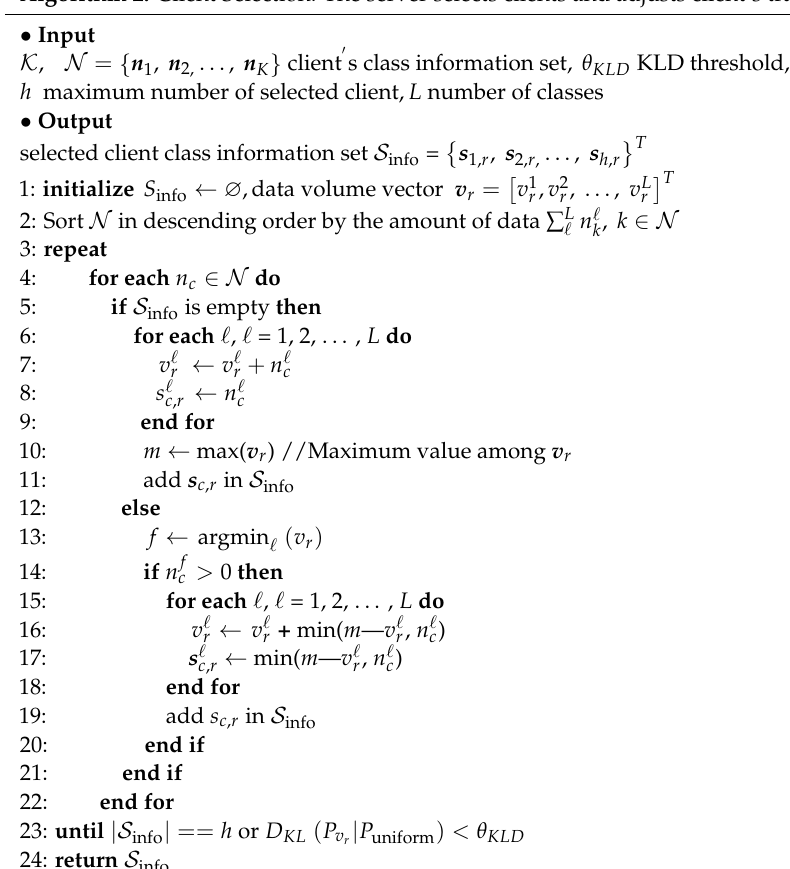
Algorithm 2. Client Selection. The server selects clients and adjusts client’s training